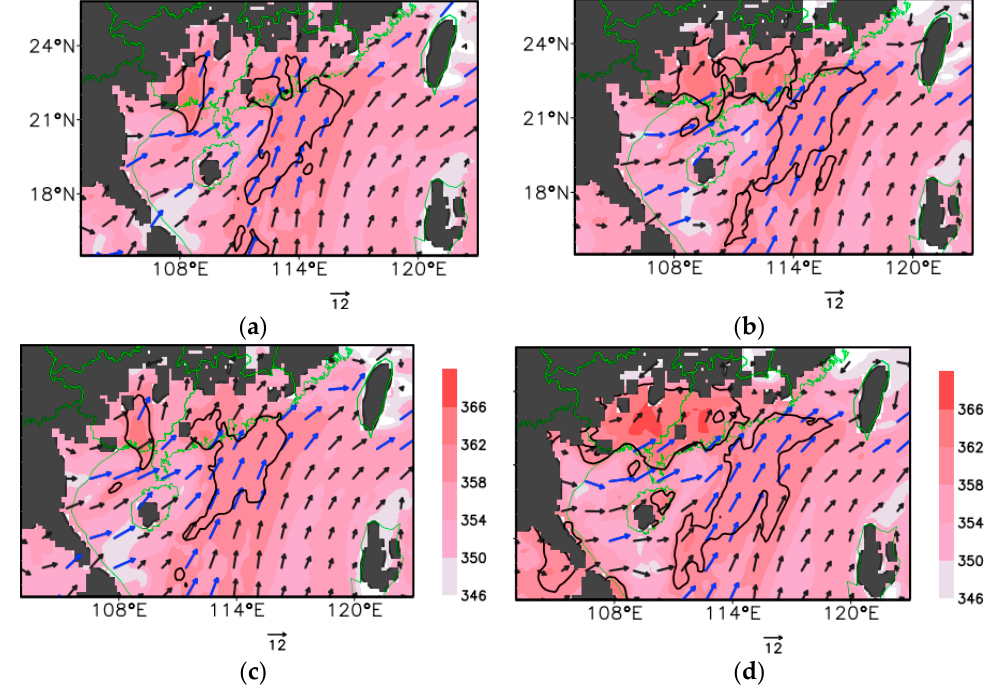
Figure 7. Potential pseudo-equivalent temperature ( θ se , shaded every 4 K; the thick solid lines denote the distribution at 350 K) and horizontal wind from the D1 simulation at 950 hPa (the blue bars denote wind speed exceeding 12 ms − 1 ) valid at ( a ) 2200 UTC on 19 May and at ( b ) 0000, ( c ) 0200, and ( d ) 0400 UTC on 20 May; the shaded regions in gray indicate the topography.